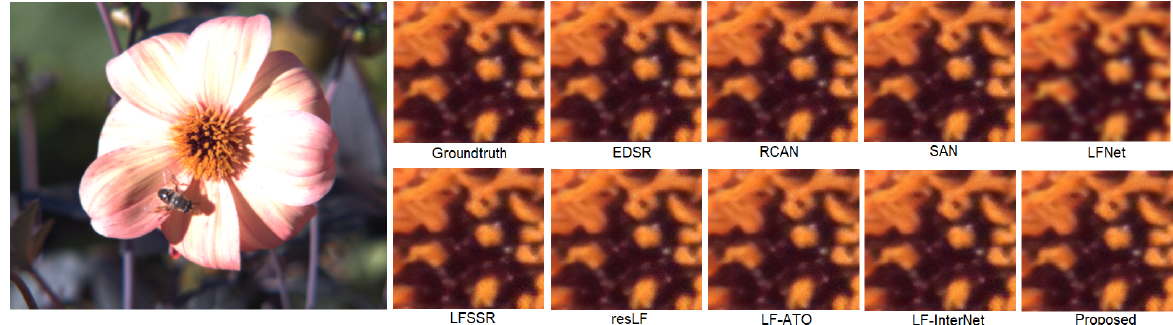
Figure 3. Visual results of the methods and the proposed one of 4 × SR.